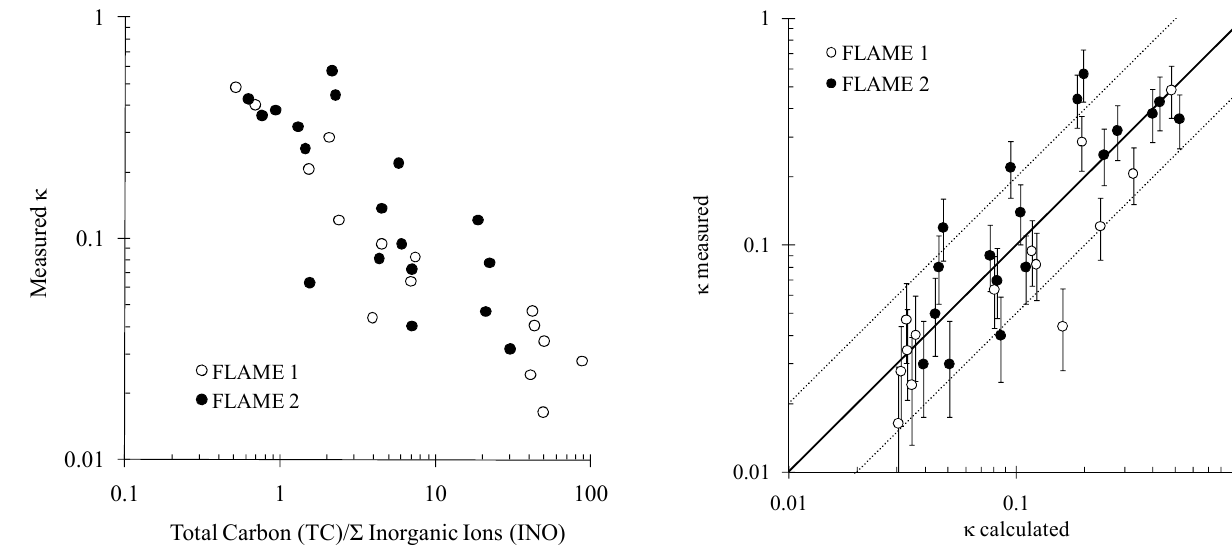
Fig. 7. HTDMA-derived hygroscopicity parameter κ measured for 100nm dry diameter particles vs. the ratio of total carbon (EC+OC) mass concentration to the sum of the mass concentration of in- organic ions (INO). Composition data were computed from IM- PROVE data as discussed in the text. Data are shown for each FLAME 1 and FLAME 2 chamber burn that has available com- position data.